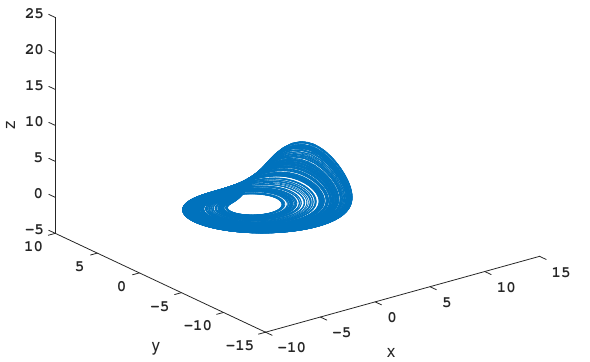
Figure 7. The chaos diagram of Rössler’s system at initial condition x 0 = [ − 1,3, − 2 ] T .